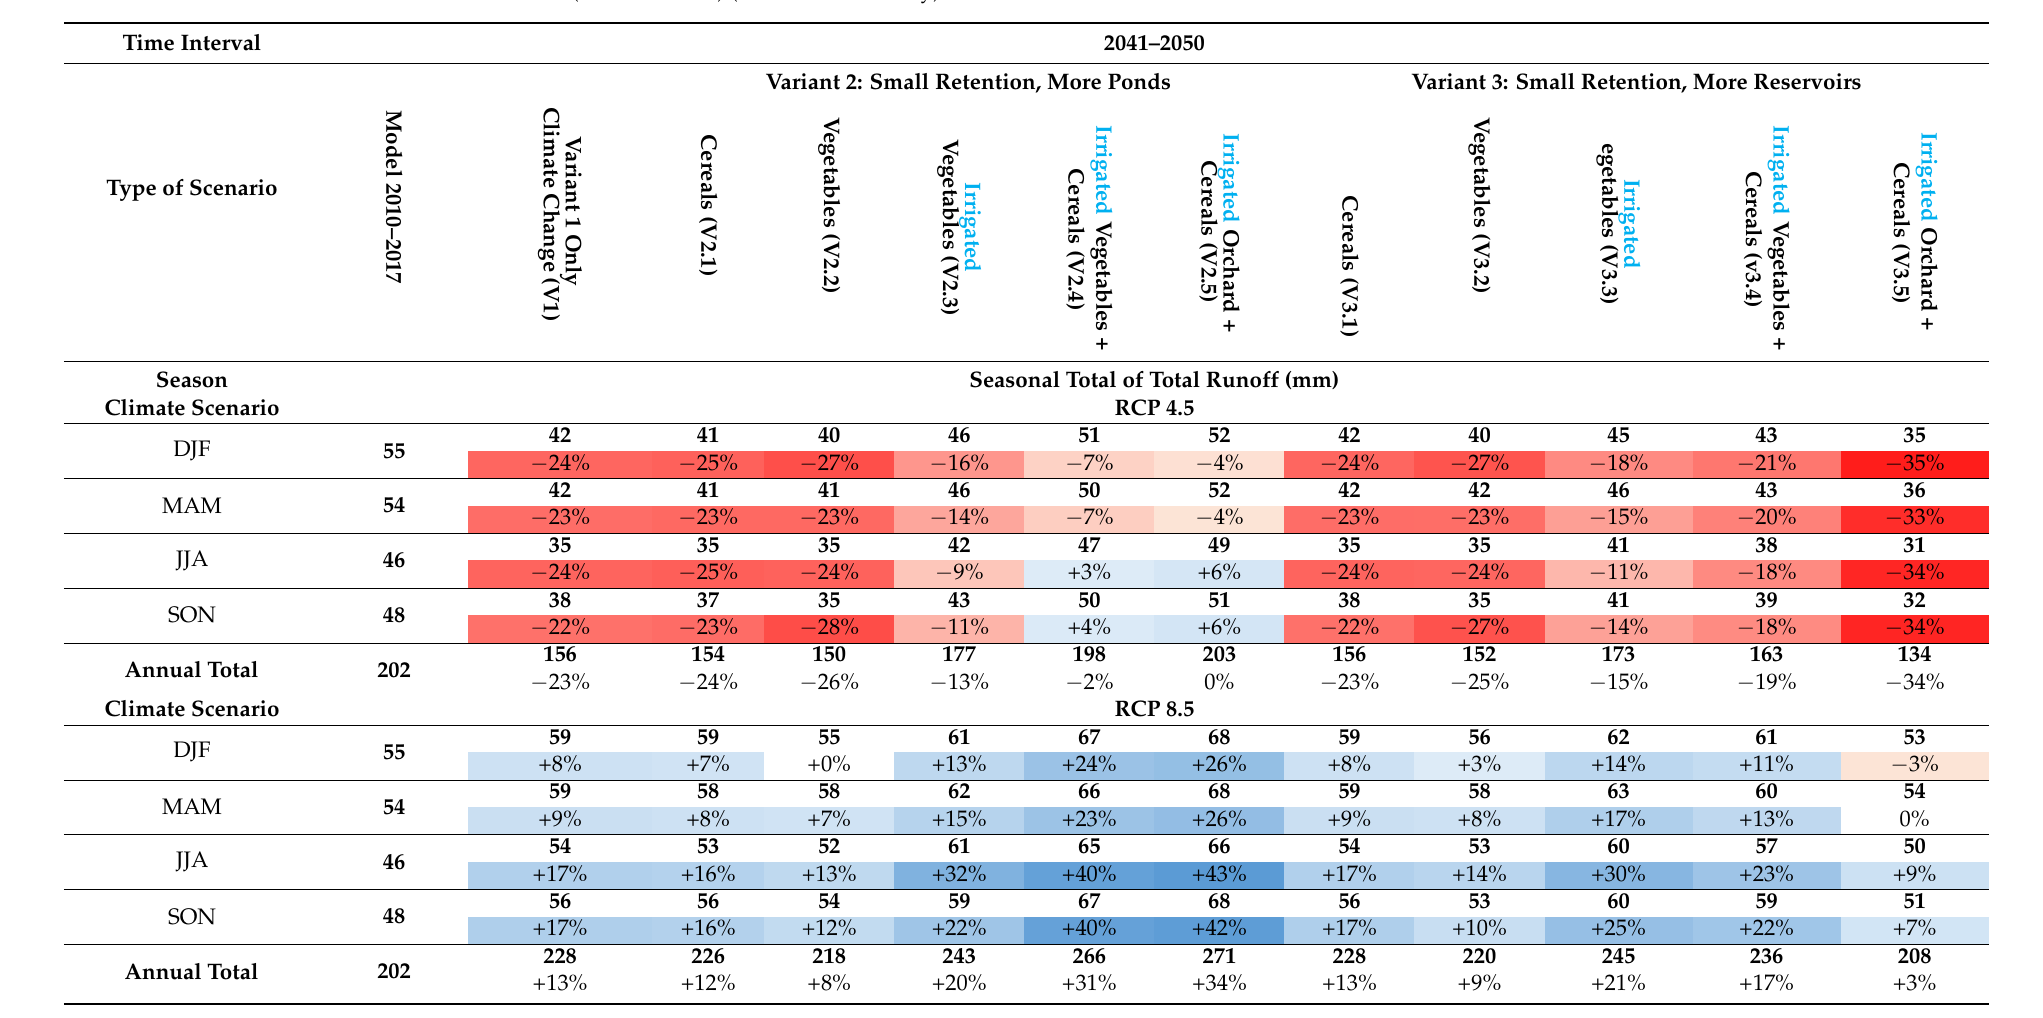
Table 5. Average total runoff in the Bystra catchment for DJF (December, January, February, etc.), MAM, JJA and SON in 2041–2050 in various scenarios (SWAT model, V1, V2.1-V2.5 and V3.1-V3.5) for climate scenarios RCP 4.5 and RCP 8.5. Numbers in red (decrease) or blue (increase) refer to a percentage change in water content in the soil (bold numbers) (author’s own